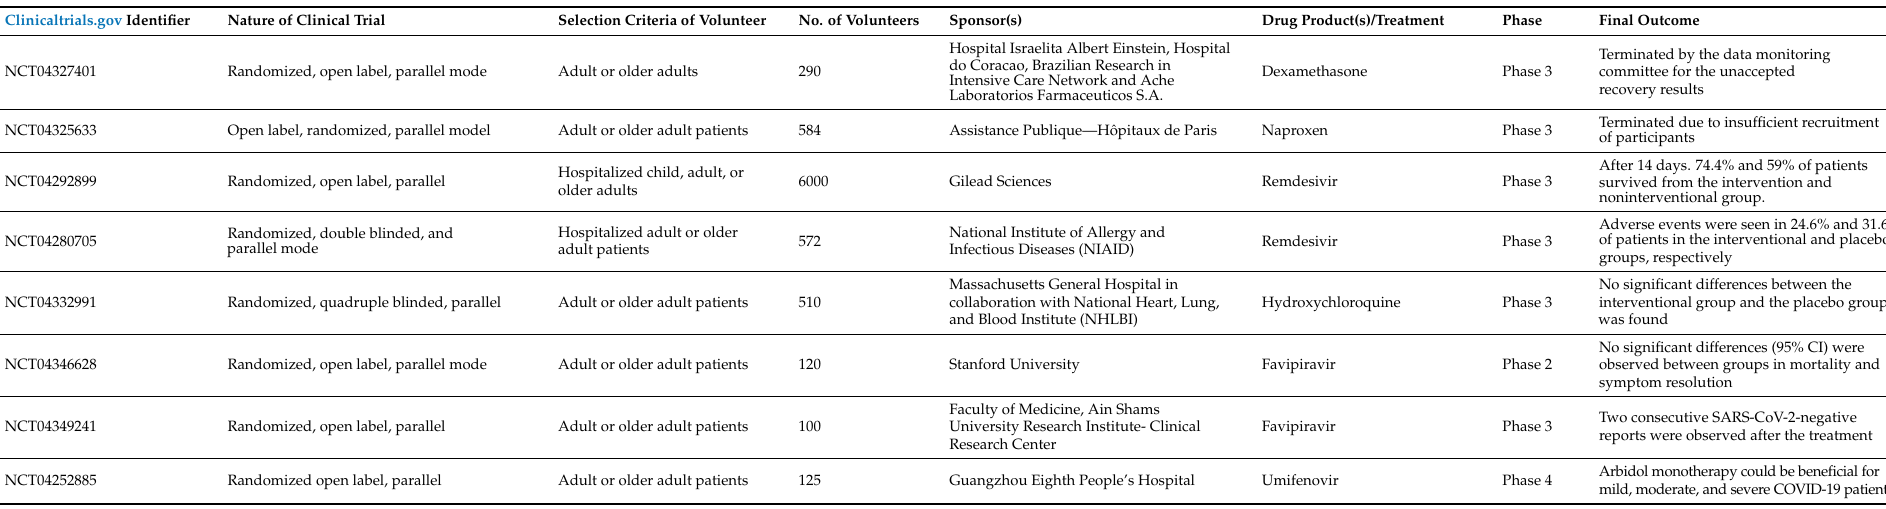
Table 2. Clinical trials of the some repurposed drugs for the treatment of COVID-19 (collected from clinicaltrials.gov; accessed on 24 January 2023).